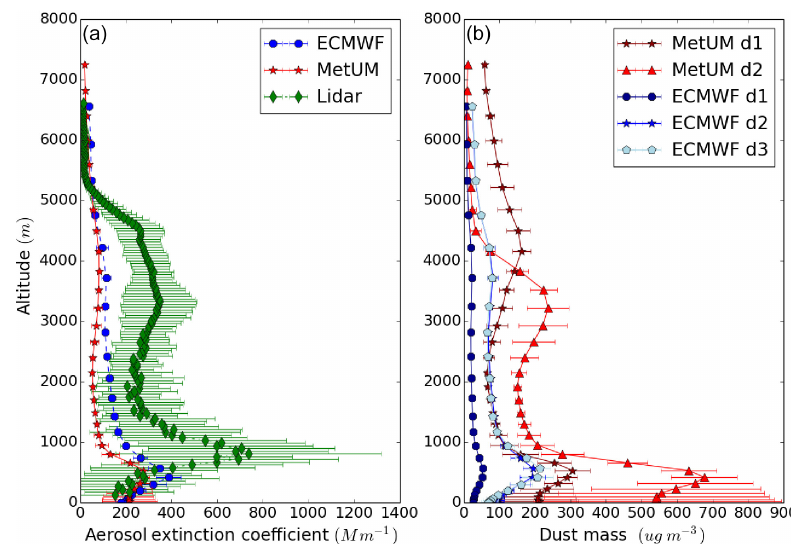
Figure 10. Case study 2, B923, 12 August, R1: (a) mean and standard deviation of the lidar (green), MetUM (red), and ECMWF (blue) extinction profiles. (b) Modelled MetUM dust concentration for divisions 1 (dark red) and 2 (red) as well as modelled ECMWF concentration for divisions 1 (dark blue), 2 (blue), and 3 (light blue) dust.